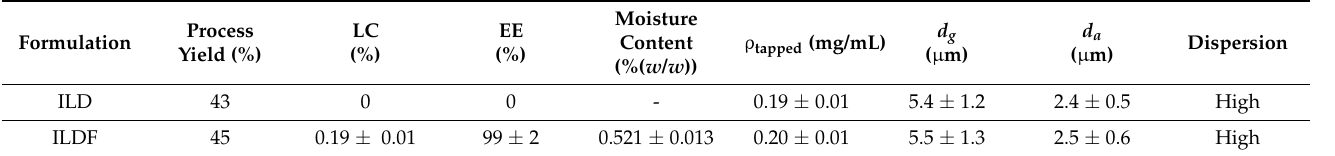
Table 2. Summary of the ILDF microparticles in comparison to the control (ILD) produced using our TTMD. Basic properties of these particles, including moisture content, d g , d a , and dispersion, are included.